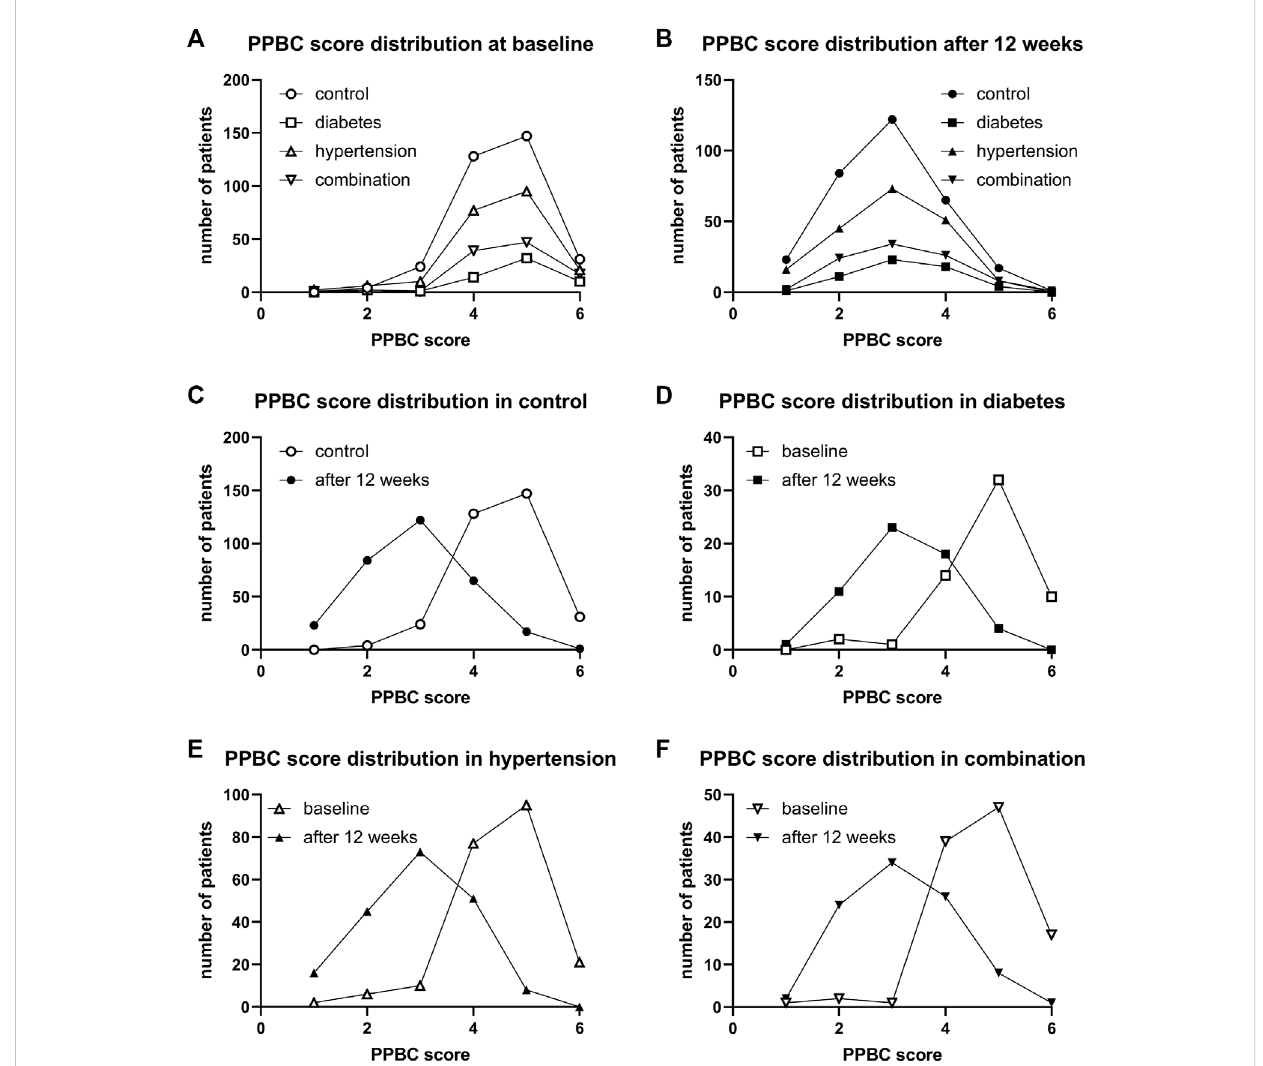
Frequency distribution of PPBC score in study II: (A) across groups at baseline, (B) across groups after 12 weeks of treatment, (C) comparison of baseline and after 12 weeks of treatment in control patients, (D) comparison in diabetic patients, (E) comparison in hypertensive patients, and (F) comparison in patients with both